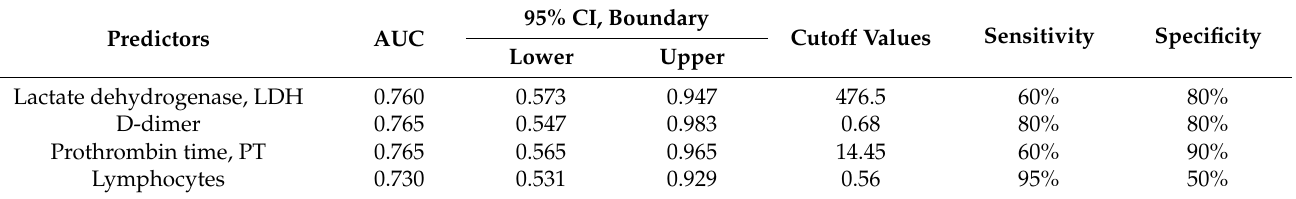
Figure 1. ROC curves for lymphocytes, D-dimer, PT, and LDH in prediction of encephalopathy in patients with COVID-19. Table 6. Characteristics of the area under the curve and the cutoff values for the studied